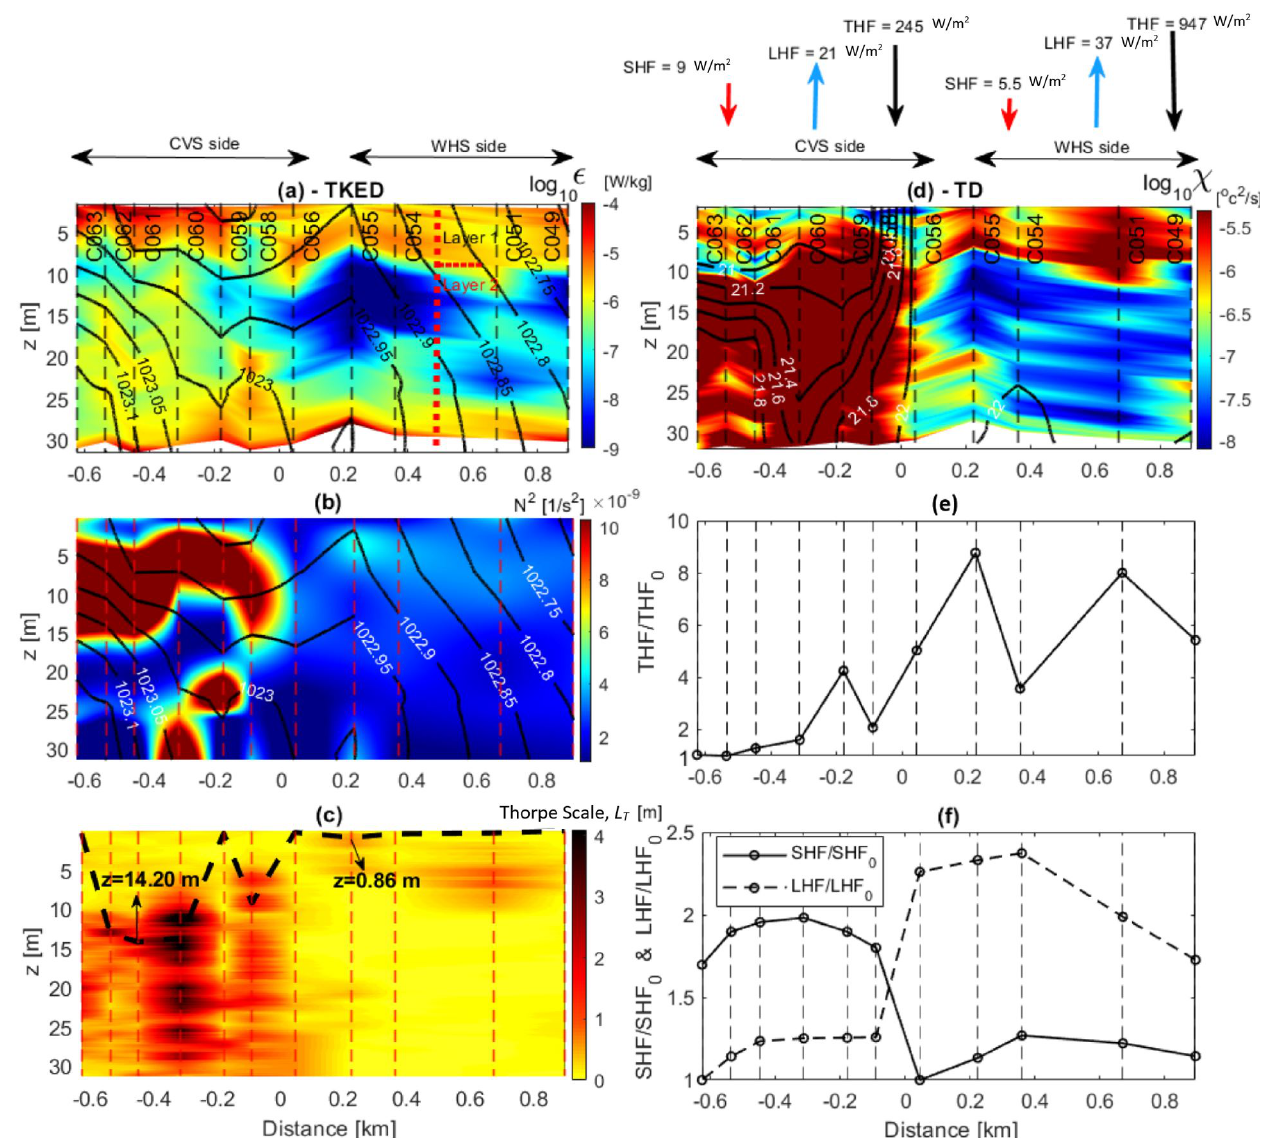
Figure 3. ( a ) The TKED vertical profiles across the front. The red-dashed lines separates the two observed layers of TKED. ( b ) The buoyancy frequency square, N 2 , is shown. The black contour lines in ( a , b ) show the density. ( c ) The one meter-mean of the Thorpe sca, L T . The black-dashed line presents the maximum depth that the water parcel can reach the water surface due to the vertical overturning. ( d ) The TD vertical profiles. The black counter lines of temperature are depicted. The direction and the average value of the water surface side sensible heat flux (SHF), latent heat flux (LHF), and turbulent heat flux (THF) are presented on both sides of the front by arrows (the arrows are not scaled). ( e ) The water surface THF of every upcast divided by its minimum value, THF 0 , is shown. ( f ) The SHF and LHF at the water surface divided by their minimum values named as SHF 0 and LHF 0 , respectively, are shown. The direction and the average value of the SHF, LHF, and THF for graphs ( e , f ) are presented on both sides of the front by arrows (the arrows are not scaled) at the top of the graph ( d ). The arrows shows the values of heat fluxes on the water side. The vertical black ( a , d – f ) and red ( b , c ) dashed-lines present the location of the VMP200 deployments at different distances from the front center, shown by zero